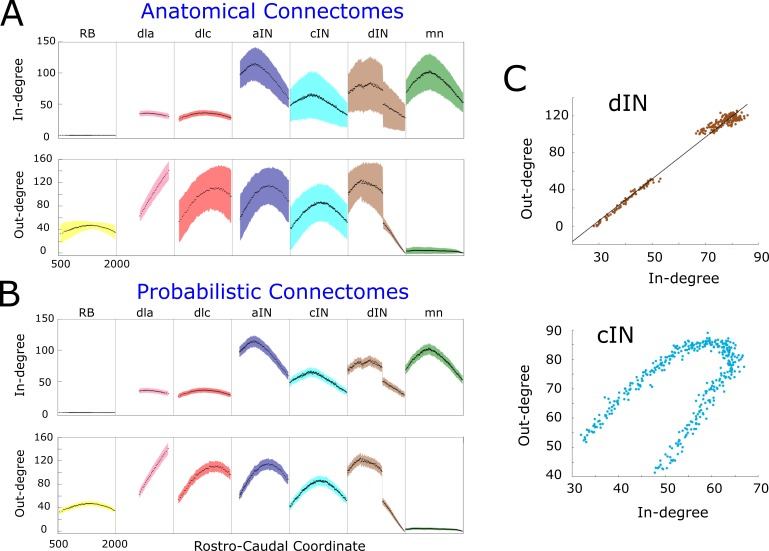
In- and out-degrees.(A-B) Average in/out-degree and standard deviation for each cell in anatomical (A) and probabilistic (B) connectomes. Neurons are divided by cell type and their degrees are plotted as a function of their rostro-caudal (RC) position. (C) Scatter plots of in- vs out-degree for CPG neuron cINs and dINs (top) and cINs (bottom): light-blue and brown dots correspond to cIN and dIN neurons, respectively. Black line shows the linear regression model for dINs (r = 0.99).